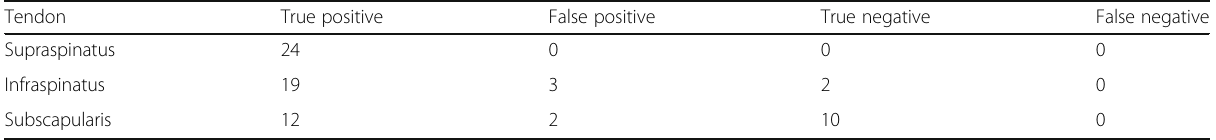
Table 5 Detection of different tendinous tears by combined CTA and bursography compared with arthroscopic findings, such results are about the arthroscopically treated cases only (24 cases), and this is not applicable for the rest of cases (6 cases) Tendon True positive False positive True negative False negative Supraspinatus 24 0 0 0 Infraspinatus 19 3 2 0 Subscapularis 12 2 10